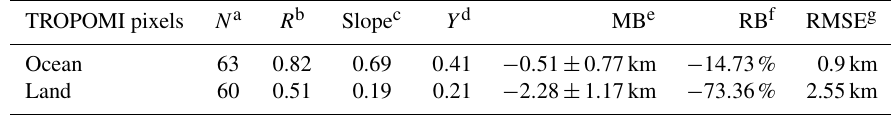
Table 3. Statistics of the comparison between TROPOMI and EARLINET ALH data sets. TROPOMI pixels N a R b Slope c Y d MB e RB f RMSE g Ocean 63 0.82 0.69 0 . 41 − 0 . 51 ± 0 . 77km − 14 . 73% 0.9km Land 60 0.51 0.19 0.21 − 2 . 28 ± 1 . 17km − 73 . 36% 2.55km